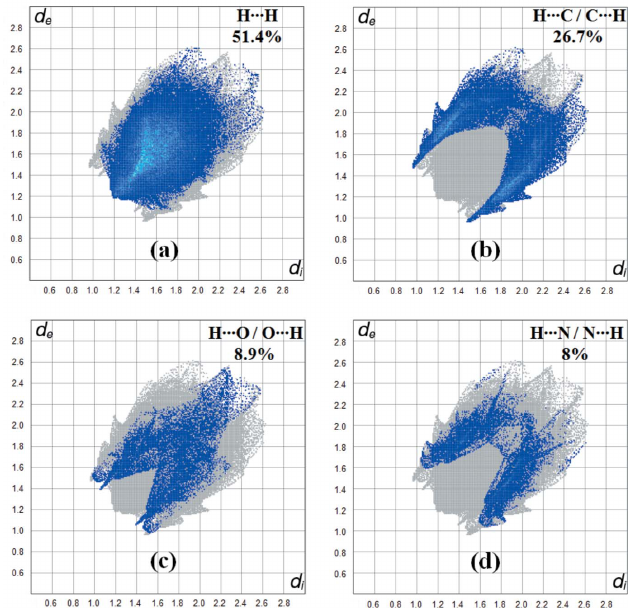
Figure 6 Two-dimensional fingerprint plots with a d norm view of the ( a ) H (cid:3)(cid:3)(cid:3) H (51.4%), ( b ) H (cid:3)(cid:3)(cid:3) C/C (cid:3)(cid:3)(cid:3) H (26.7%), ( c ) H (cid:3)(cid:3)(cid:3) O/O (cid:3)(cid:3)(cid:3) H (8.9%) and ( d) H (cid:3)(cid:3)(cid:3) N/N (cid:3)(cid:3)(cid:3) H (8%) contacts in the title